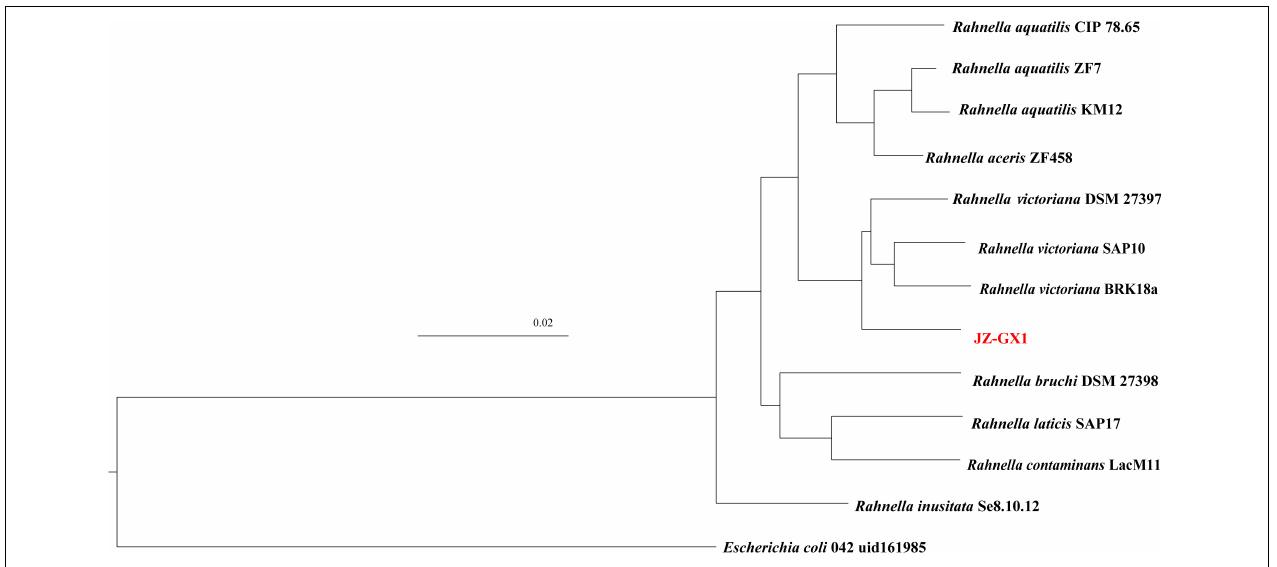
FIGURE 2 | Taxonomic assignment of strain JZ-GX1. Escherichia coli 042 uid161985 was used as outgroup. Bar, 0.02 substitutions per nucleotide position.